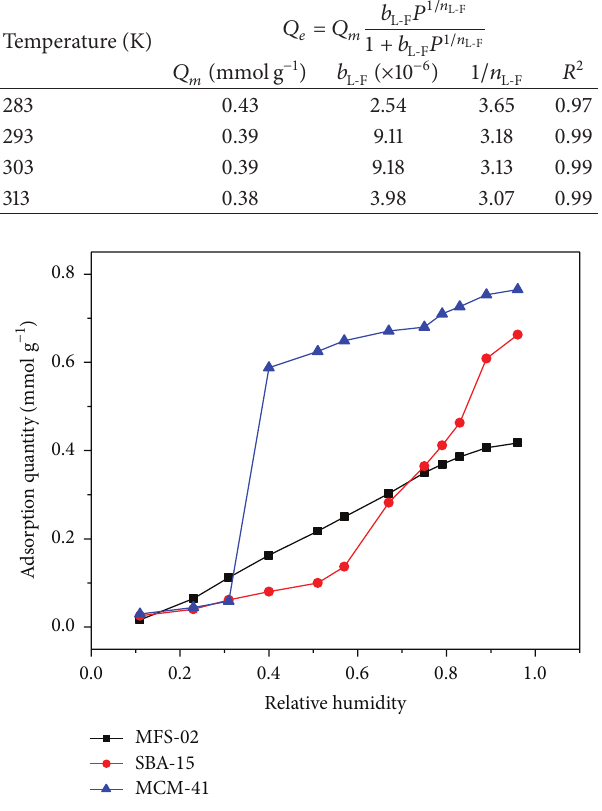
Figure 7: Comparison of the adsorption isotherms of water vapor on the MFS-02, SBA-15, and MCM-41 at 303